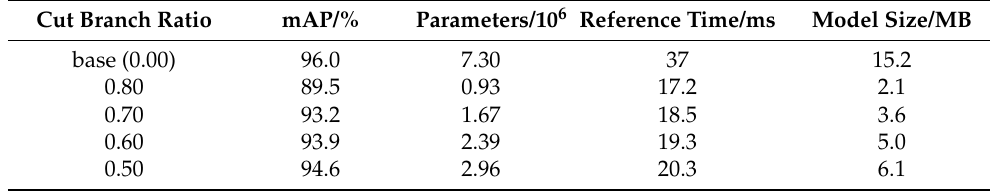
Table 3. Parameter comparison of the detection models under different channel pruning rates (This table mainly compared the model running speed, size and mAP under different pruning rates).